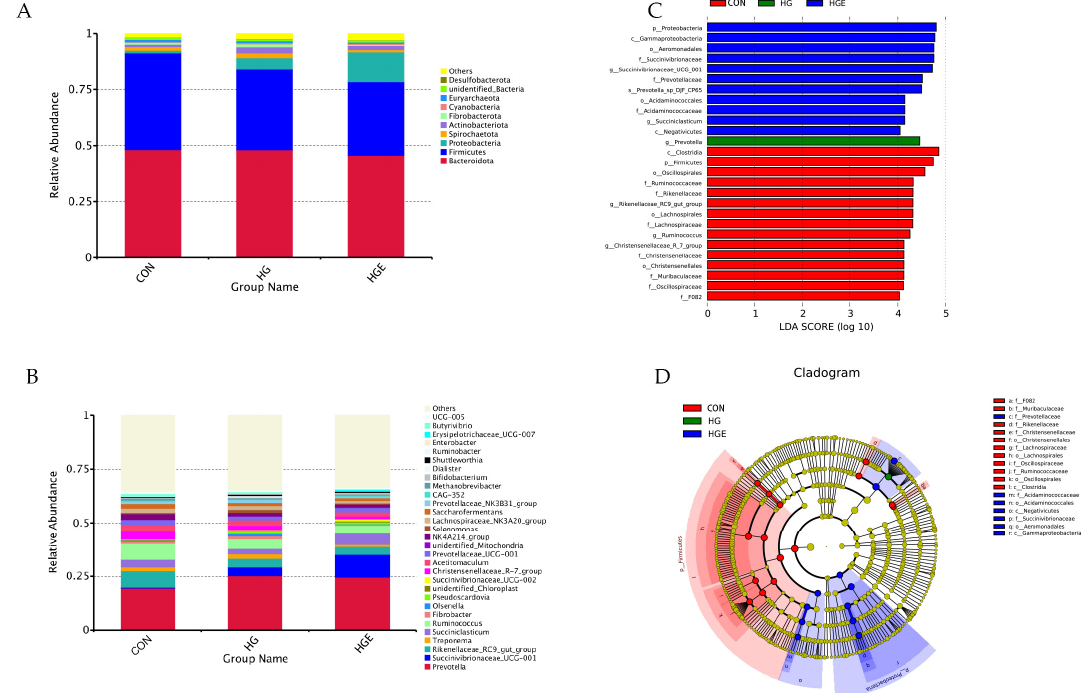
Figure 5. Effect of vitamin E on bacterial community relative abundance and lefse difference of subacute ruminal acidosis cows induced by high concentration at phylum and genus levels. The composition of rumen microflora at phylum ( A ) and genus ( B ) levels in cows. ( C ) Linear discriminant analysis (LDA) effect size (LEfSe) analyses of bacterial communities in cows based on the threshold of LDA score > 3. ( D ) Cladogram of the discovered biomarkers.